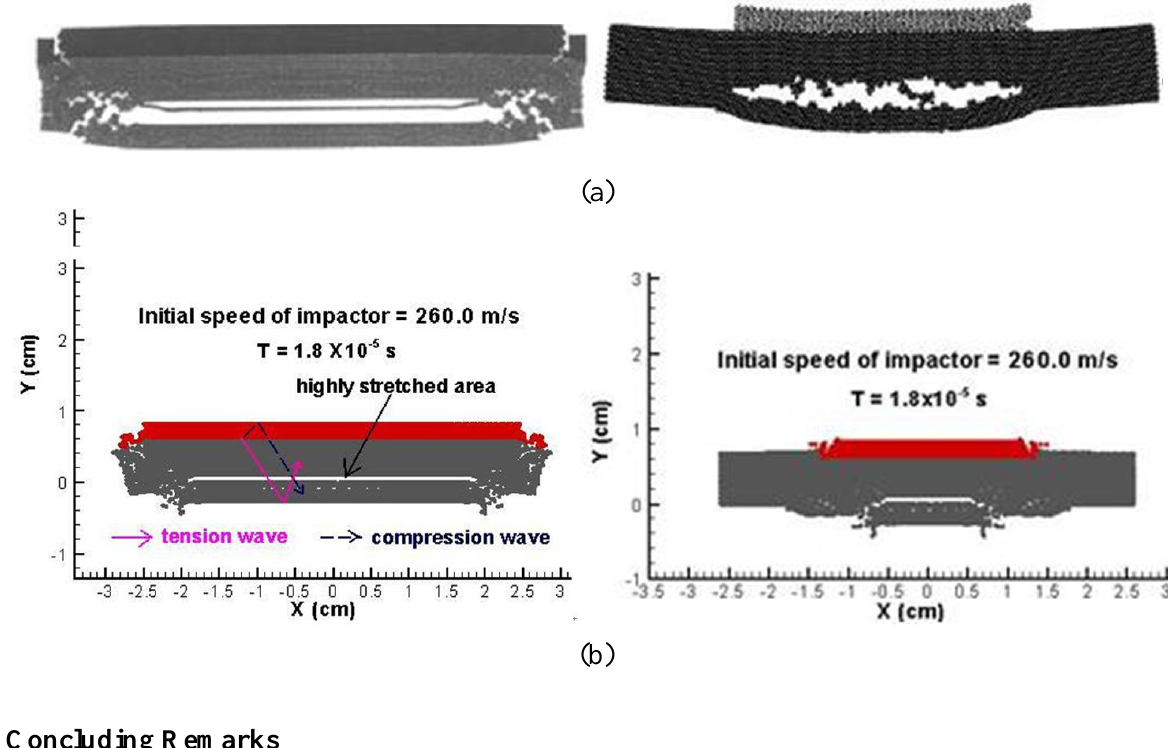
Figure 17. Qualitative comparison of spall crack formation of HPLM with MD. (a)